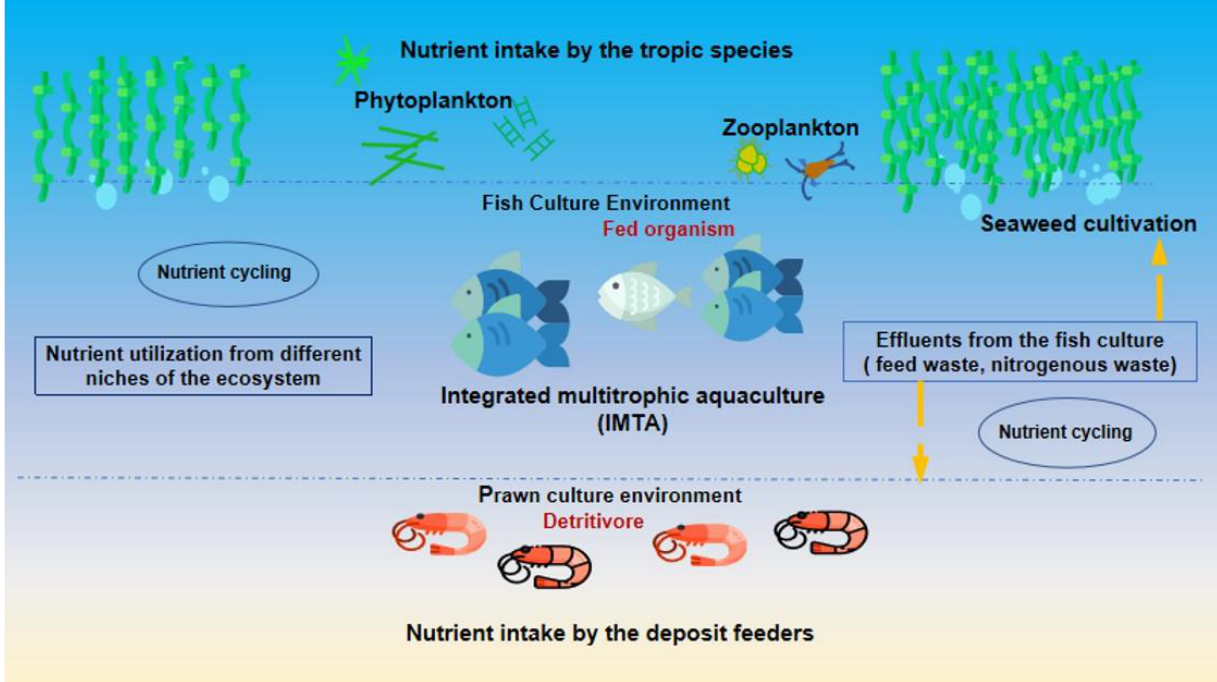
Figure 4. Graphical illustration of IMTA depicting efficient utilization of nutrient recycling system.